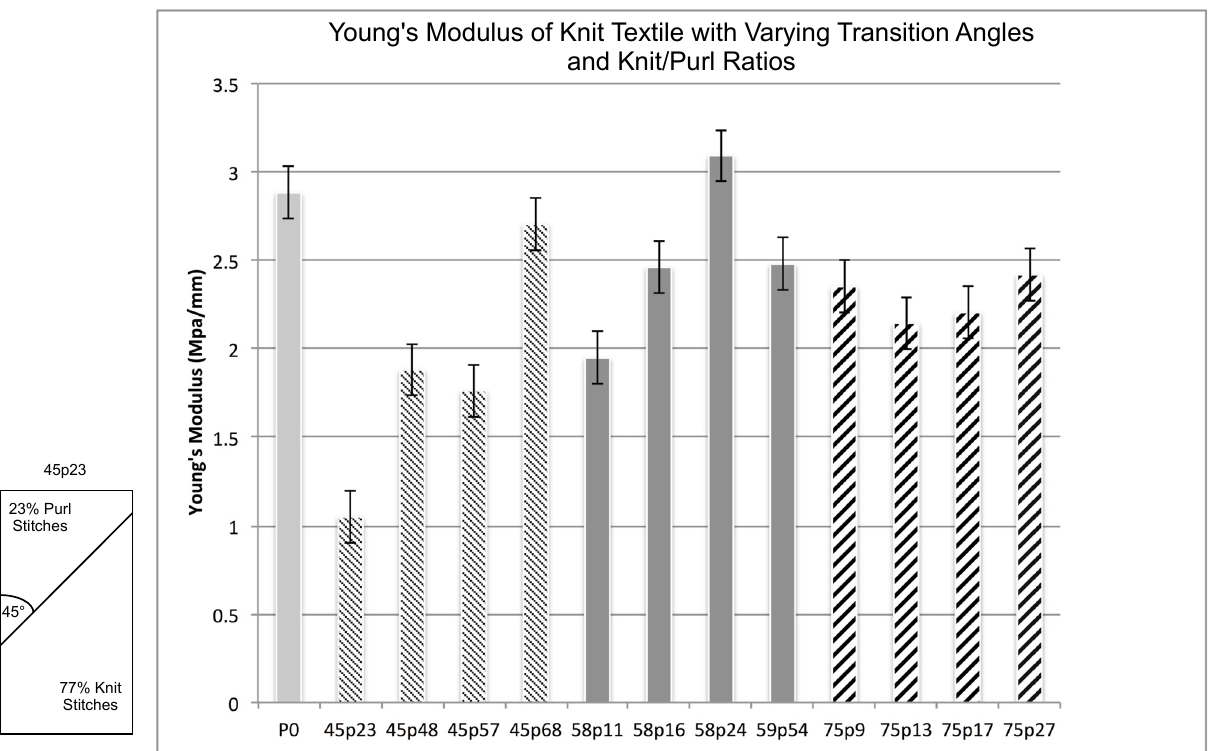
Figure 7. Young’s modulus comparisons between transition angles and lengths,